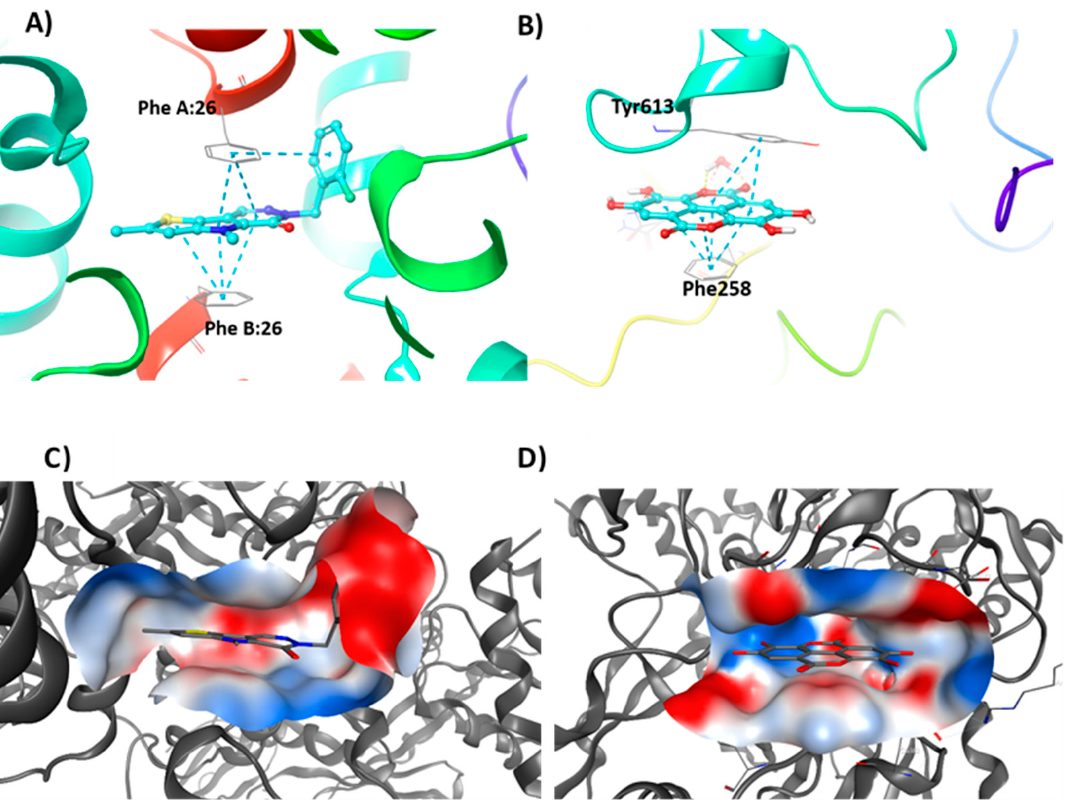
Figure 6. ( A ) Crystal structure of PKM2 activator in its binding site, PDB ID: 3H6O. ( B ) Crystal structure of compound 1 and glycogen phosphorylase, PDB ID: 4YUA. ( C ) Electrostatic map of the PKL binding pocket. The backbone is illustrated as a grey ribbon. ( D ) Electrostatic map of the glycogen phosphorylase binding pocket. The backbone is illustrated as a grey ribbon.